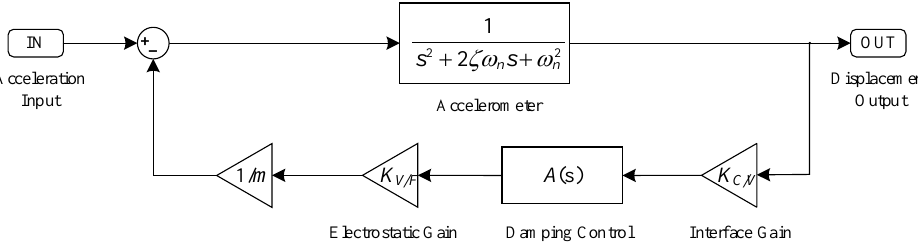
Figure 5. Block diagram of the electrostatic active damping control system for the micromachined silicon resonant accelerometer.